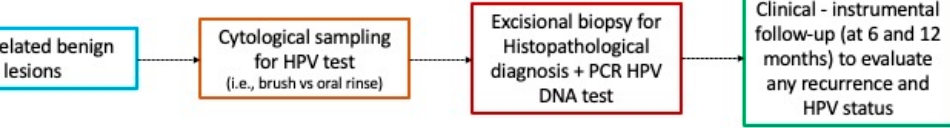
Figure 2. Proposed protocol for suspected HPV-related oral lesions.